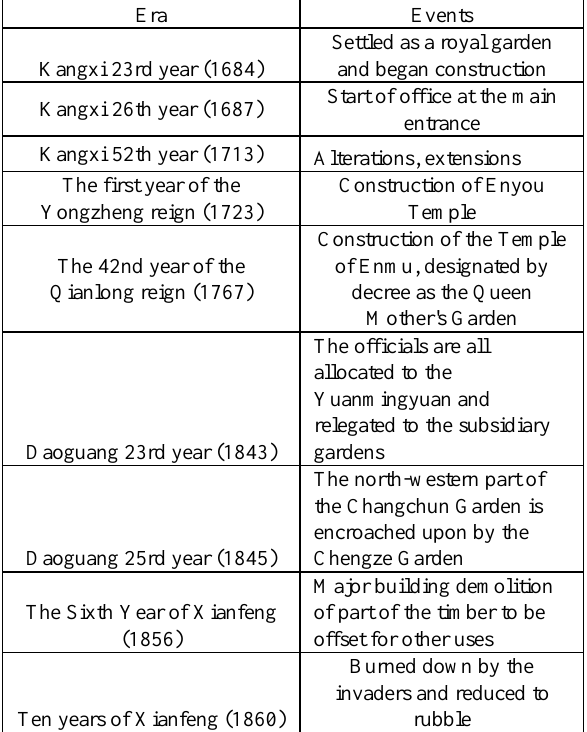
Table 1 . Chronology of the Great Chronicle of Changchun Garden.